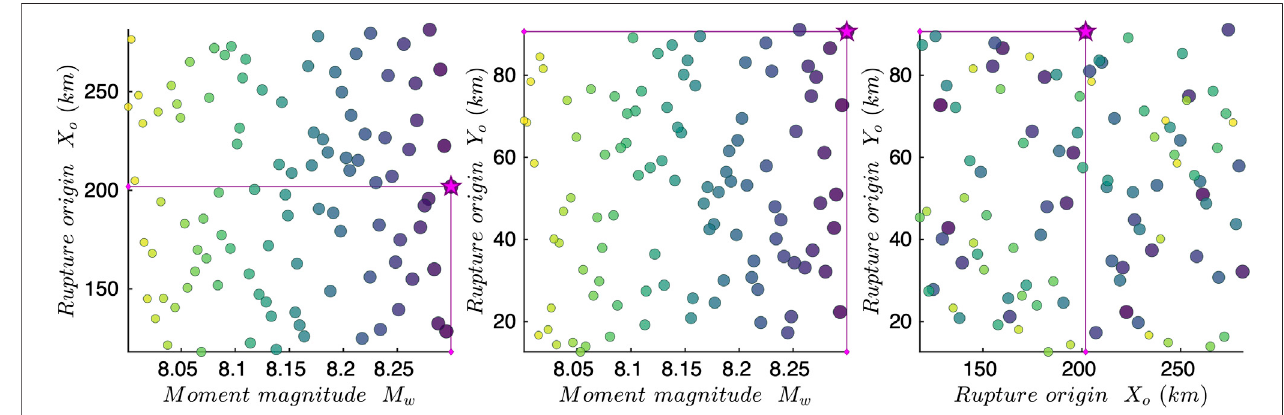
FIGURE 4 | The input parameters ( M ω , X o , Y o ) for the 100 scenarios used to train the emulator generated by Latin Hypercube Design. The input parameters projected on M ω − X o plane (left) , M ω − Y o plane (middle) , and X o − Y o plane (right) . The dot color corresponds to moment magnitude ( M ω ). Sample no. 1is marked with a star.